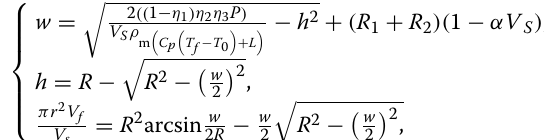
where T and T 0 are the surface and ambient tempera- tures, respectively; ε is the emissivity of the material; and σ is the Stephen–Boltzmann constant for radia- tion. Convection and radiation can be summed to a sin- gle heat transfer coefficient and integrated into the FE analysis. In this model, heat transfer coefficients of 120 and 40 W / m 2 · ◦ C were applied to the bottom sur- face and sides, respectively [28, 30].